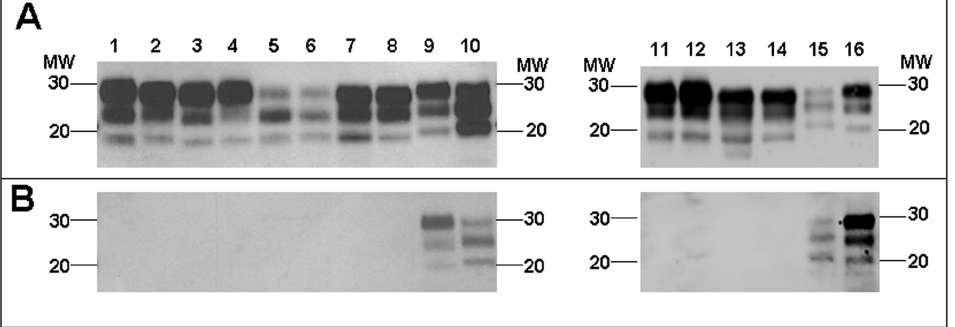
Figure 1. Electrophoretic profiles and antibody labelling of PrP res in BSE-derived prions. PrP res was detected by western blot using the mAbs Sha31 (A) and 12B2 (B) in the different BSE-derived prions propagated either in natural hosts or in transgenic mouse models over-expressing their corresponding PrP C sequence: cattle-BSE (lanes 1 and 11), BoTg-BSE (lanes 2 and 12), sheep-BSE (lane 3), OvTg-BSE (lane 4), pig-BSE (lane 5), PoTg-BSE (lane 6), mouse-BSE (lane 7), MoTga20-BSE (lane 8), human-vCJD (lane 13), HuTg-BSE (lane 14). Sheep-scrapie (lane 9), mouse-RML (lane 10), human-sCJD (lane 15) and atypical cattle-BSE H (lane 16) were included as control non-BSE related prions. Panels A and B were loaded with the same quantities of PrP res extracted from each sample. MW, molecular weight in kilodaltons.